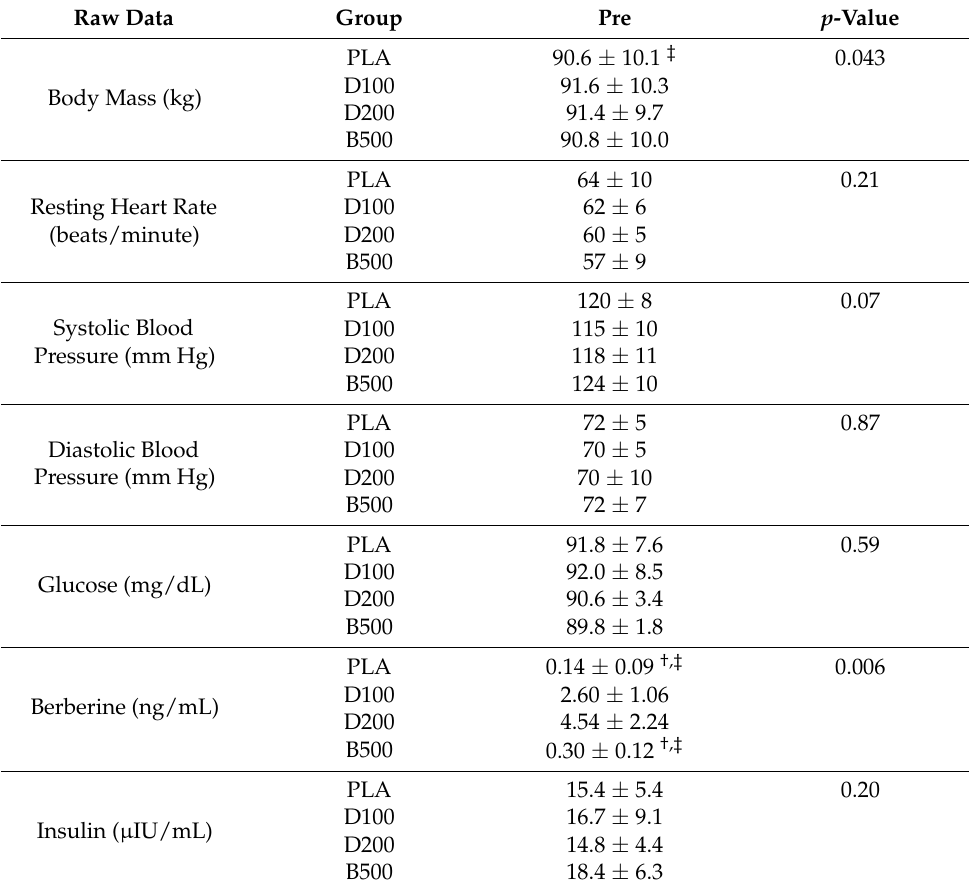
Table 2. Baseline body mass, hemodynamic, glucose, insulin, and